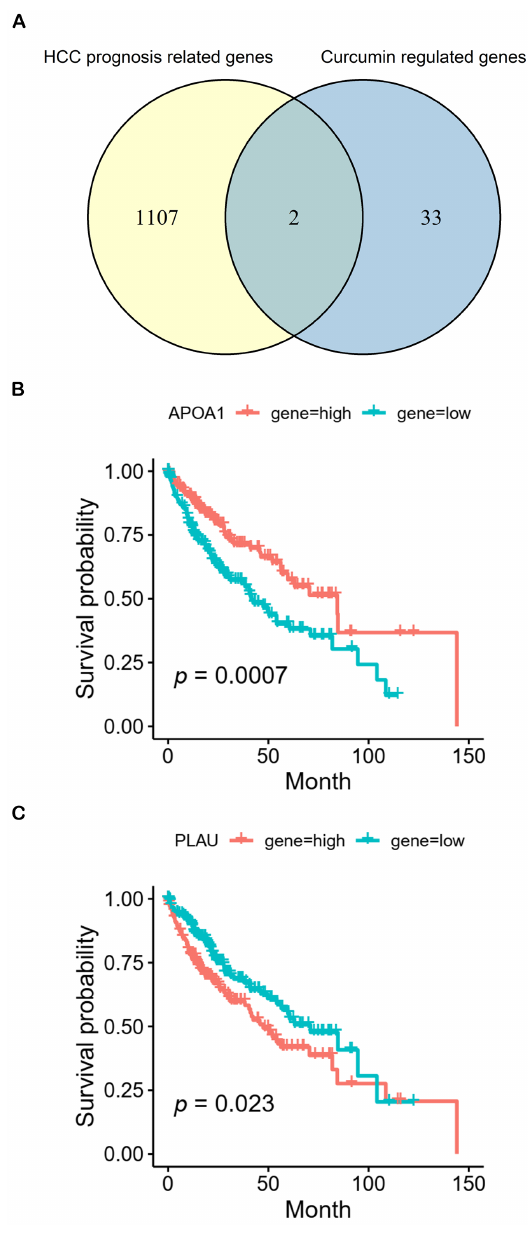
Figure 2. Prognostic analysis. ( A ) There are two common genes ( APOA1 and PLAU ) between 1109 genes ( p < 0.05) related to prognosis of HCC (yellow) and 35 DEGs (blue). ( B , C ) Kaplan-Meier analysis of overall survival for APOA1 and PLAU , respectively.